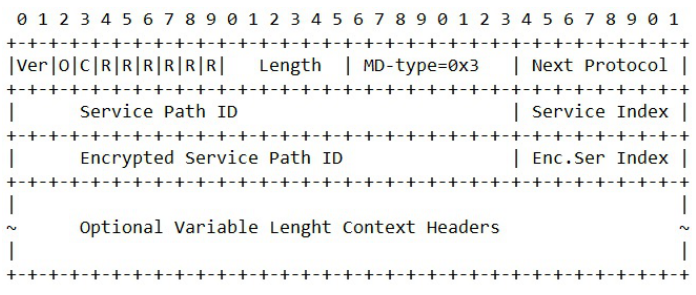
Figure 20. The Network Service Header structure.